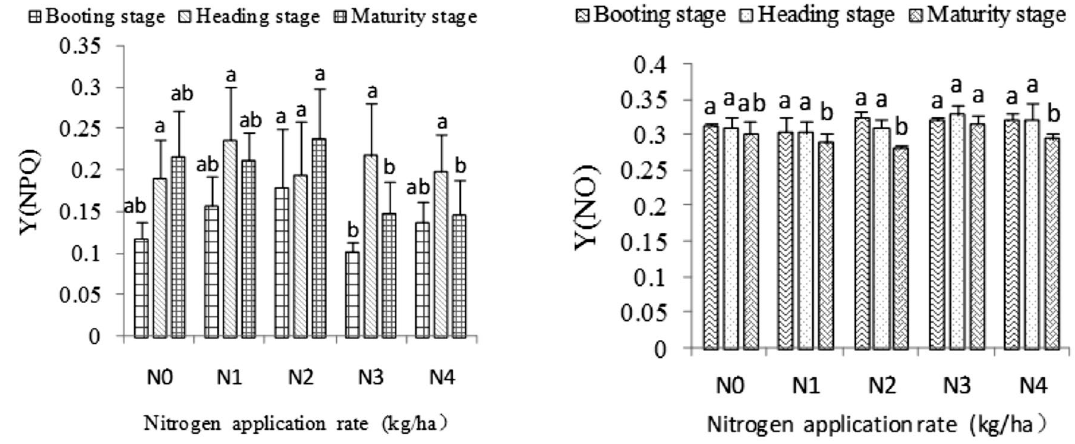
Figure 4. Effects of different nitrogen application rates on the quantum yield of non-photochemical quenching. Effective panicle Treatment number (m −2 ) Spikelets per panicle